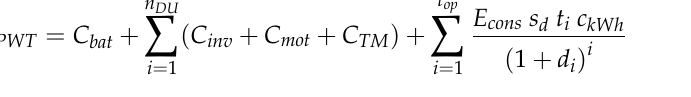
Figure 8. Variation of powertrain architectures. 8 ( a ) Base version; 8 ( b ) 2 Rear motors; 8 ( c ) Booster, 1 Rear motor; 8 ( d ) Booster, 2 Rear motors; 8 ( e ) 2 Boosters, 1 Rear motor; 8 ( f ) 4 motors.